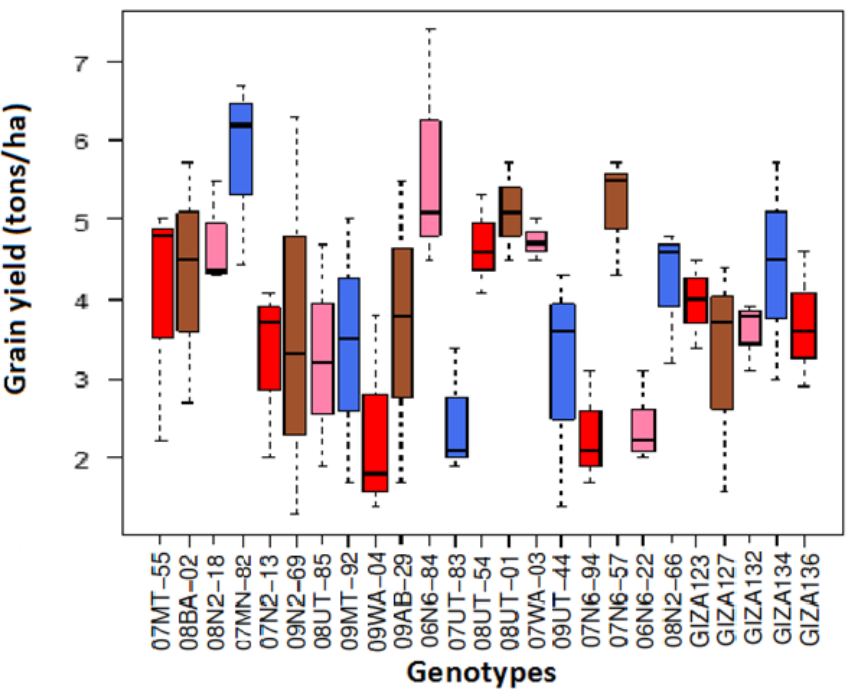
Figure 1. Boxplots for mean grain yield (GY) for 25 genotypes across the three environments. In E2, the most resistant genotypes to leaf rust disease were 07N2-13, 09N2-69, 09AB-29, 08UT-85, 09MT-92, and 08N2-66, where they recorded 4, while the most susceptible genotype to leaf rust was 07UT-83, where it recorded 63 (Supporting Information, Table S6). In E3, the most resistant genotypes were 07N2-13, 09N2-69, 09WA-04, 09AB-29, 08UT-85, 07WA-03, 08N2-66, Giza132, Giza134, Giza127, and Giza136, where they recorded 2, while the most susceptible genotype was 09UT-44, where it recorded 85 (Supporting Information, Table S6). Overall, the most resistant genotype under the three environments to leaf rust disease was Giza 136, where it recorded 5.1, while